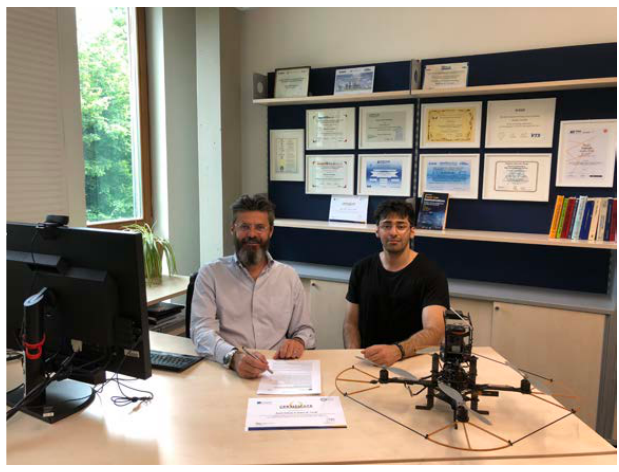
Figure 2. Prof. Tonello’s research group.